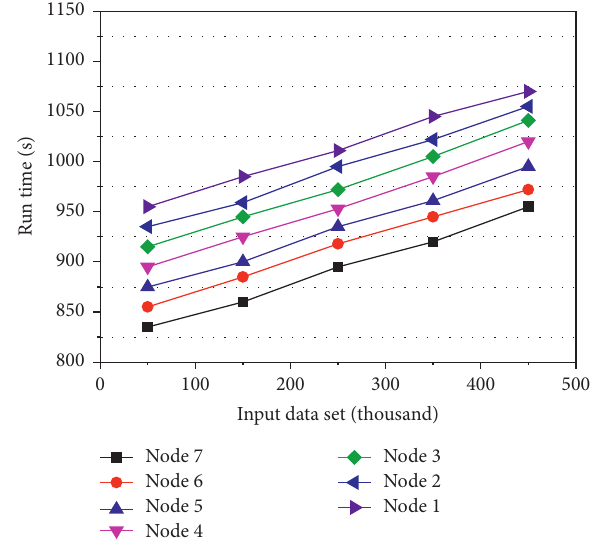
Figure 7: The run-time test